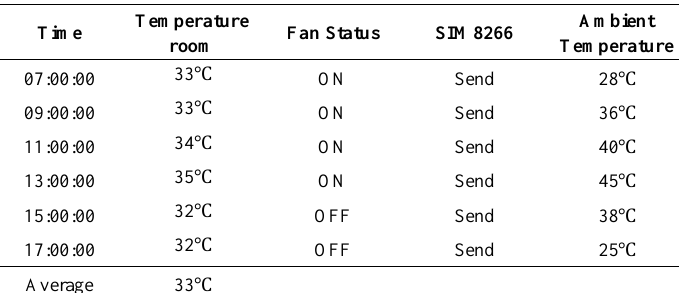
Table 6. Testing of room temperature control in hot